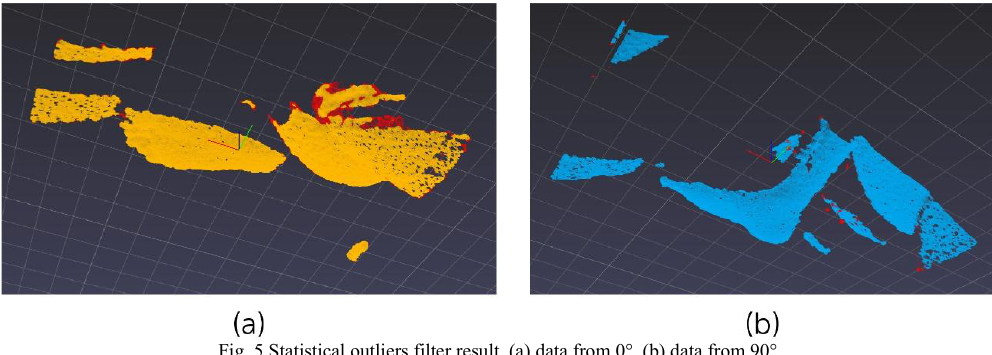
Fig. 5 Statistical outliers filter result, (a) data from 0°, (b) data from 90°